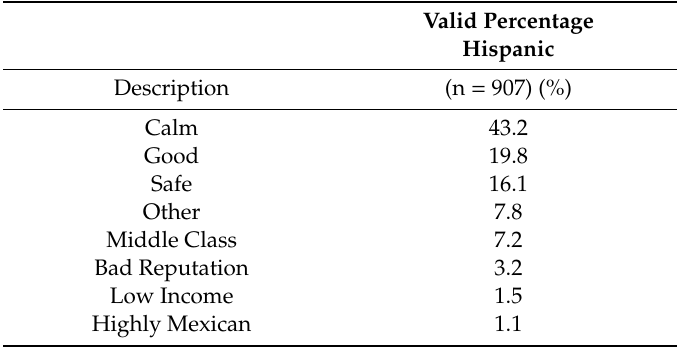
Table 3. How do you describe your